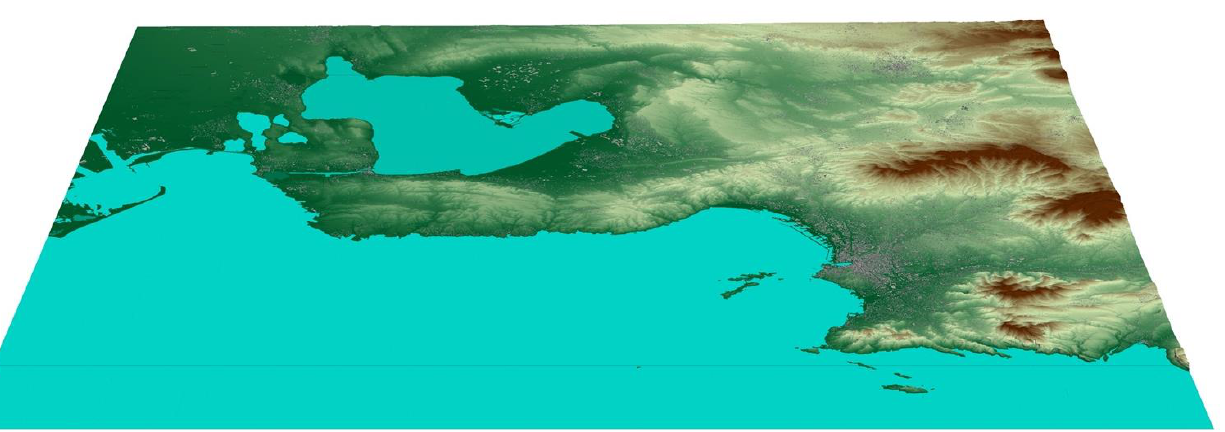
Figure 3. 3D view of the topography and buildings for the Marseille domain. North is at the top.